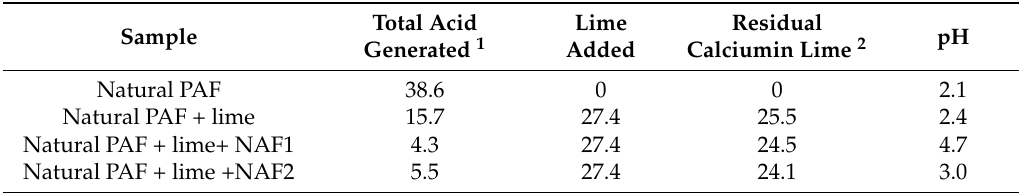
Table 6. Acidity and alkalinity balance (units all converted to kg H 2 SO 4 per tonne of PAF, for ease of comparison) and leachate pH from natural waste KLC tests at 36